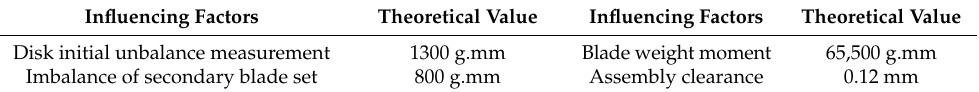
Table 10. Theoretical values of key influencing factors of secondary blade assembly process.